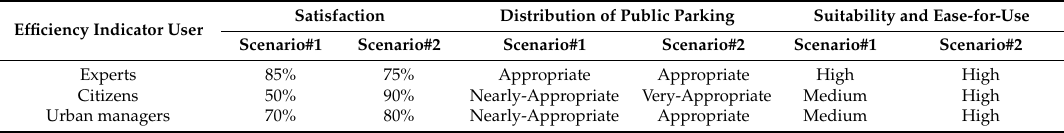
Table 2. The evaluation results of comparison between two different modes of the